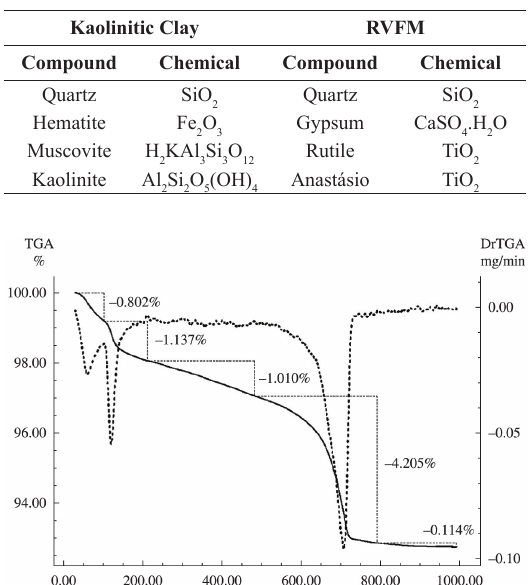
Figure 3. TG/DTG curves of sample RVFM in an N atmosphere with a heating rate of 10°C/min.